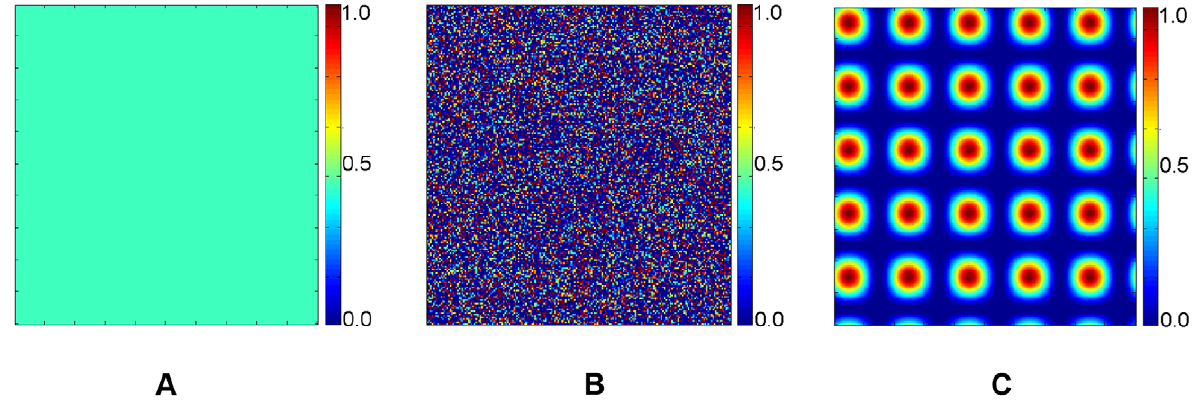
Figure 6. Different distributions of the ECM densities. (a) Uniform distribution. (b) Random distribution, i.e., the value of r ECM is completely independent of r ECM values of other automaton cells. (c) Sinusoidal-like ECM density distribution defined by Eq. (3) to mimic the obstacles for a growing tumor.